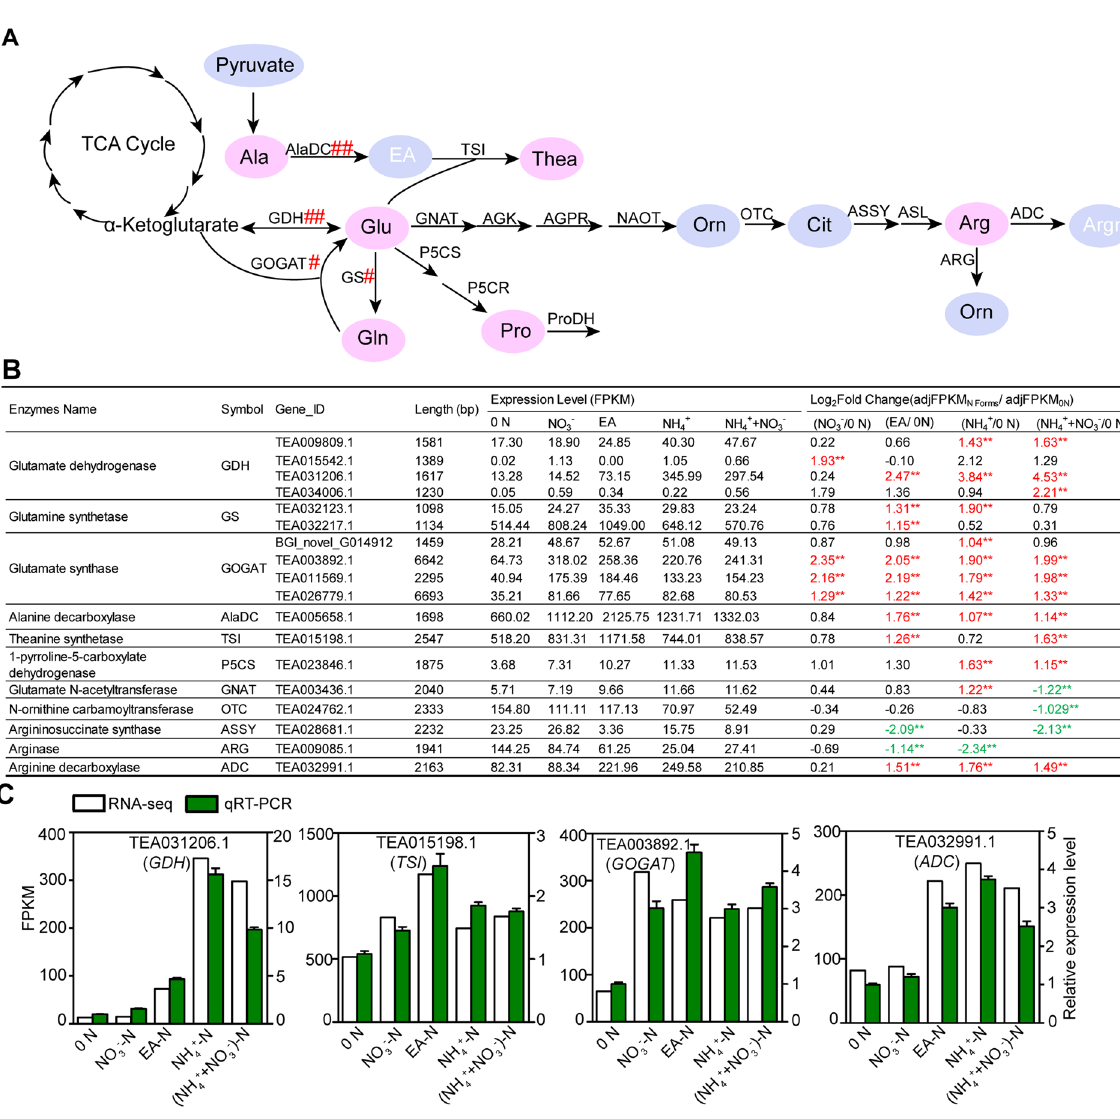
Expression of CsAspAT , CsAK and CsTHS was responsive to 0 N and N forms in tea plant root. Asp is synthesized from 2-oxaloacetate and Glu under the catalysis of aspartate aminotransferase (AspAT) (Fig. 6A). Asp can then act as precursor to produce Thr, Met, Lys and Ile which are essential for mammals 19 . In this pathway, some 120 genes encoding 25 amino acid metabolic enzymes were identified from transcrip- tome datasets (Fig. 6A and B; Table S8). Among these 120 genes, nineteen genes were differentially expressed in response to 0 N and N forms (Fig. 6B, Table S8). Especially, genes encoding CsAspAT, asparate kinase (CsAK) and threonine synthase (CsTHS) were more responsive to 0 N and N forms, suggesting important regulatory roles of these genes in Asp pathway. In this study, we observed that Asp contents in tea plant roots were generally stable under the treatments (Fig. 3B). Under these conditions, five genes encoding CsAspAT and two genes encoding CsAK were significantly upregulated by EA-N, NH 4 + -N and (NH 4 + + NO 3 − )-N, comparing with the 0 N treatment. These genes were also induced by NO 3 − -N, although were not statistically significant (Fig. 6B). These results suggested the Asp biosyn- thesis was regulated by CsAspAT under 0 N and various N forms. In addition, CsAK catalyses the first step in the conversion of Asp to Lys, Thr, Ile and Met (Fig. 6A). Therefore, reduced expression of CsAK under 0 N suggested